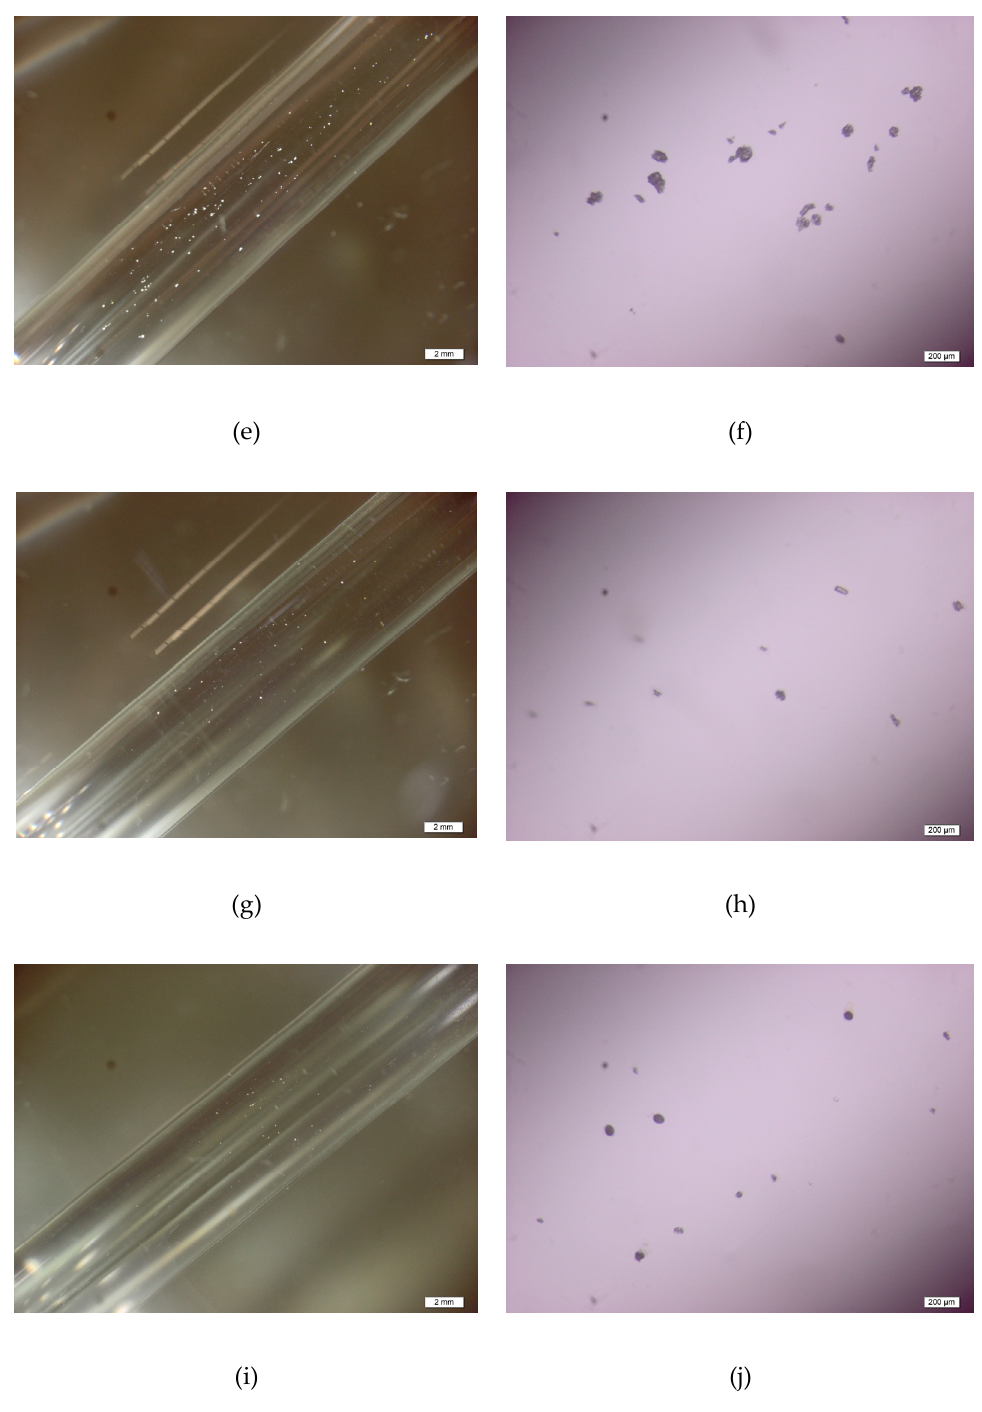
Figure 1. Effectofdifferentperoxides( a )andCaO 2 dosage( b )oncalciumprecipitationandstereomicroscope Figure 2. Effect of different peroxides ( a ) and CaO 2 dosage ( b ) on calcium precipitation and micrographs of the crystals in calcium precipitation experiments using CaO 2 -ORT ( c,d ), MgO 2 -ORT stereomicroscope micrographs of the crystals in calcium precipitation experiments using CaO 2 ‐ ORT ( e,f ), ZnO 2 -ORT ( g,h ) and control ( i,j ). The scales are 2 mm ( c,e,g,i ) and 200 µ m ( d,f,h,j ), ( c,d ), MgO 2 ‐ ORT ( e,f ), ZnO 2 ‐ ORT ( g,h ) and control ( i,j ). The scales are 2 mm ( c,e,g,i ) and 200 μ m ( d,f,h,j ), respectively.